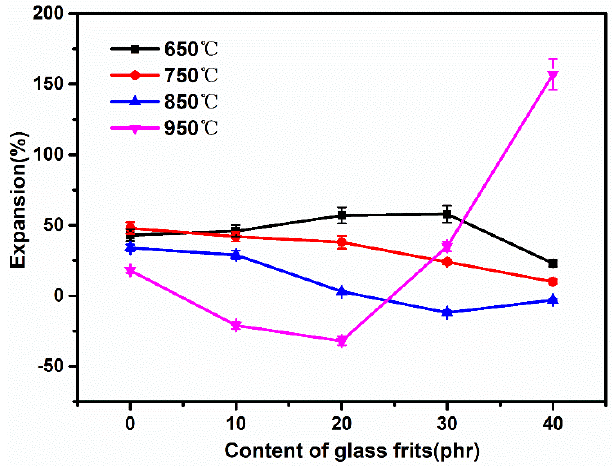
Figure 5. Volume variations in the residues at different temperatures of silicone composites.